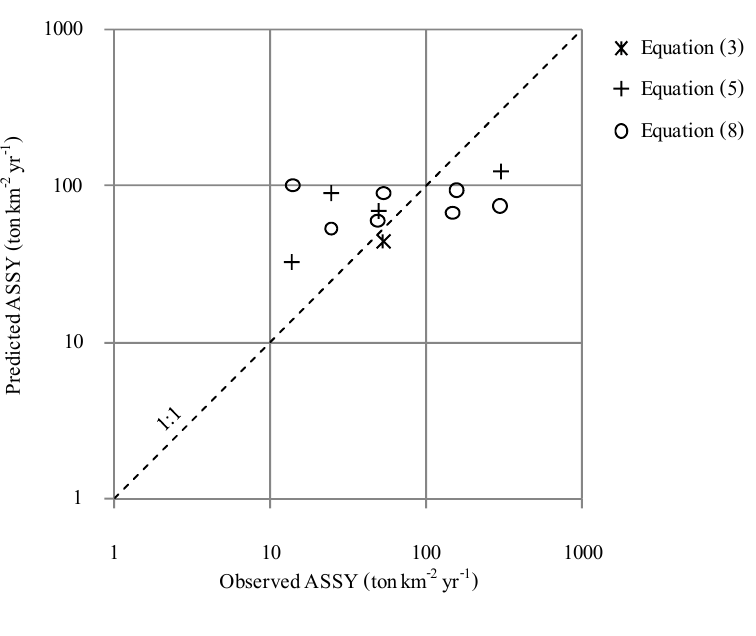
Figure 5. Validation results for ASSY